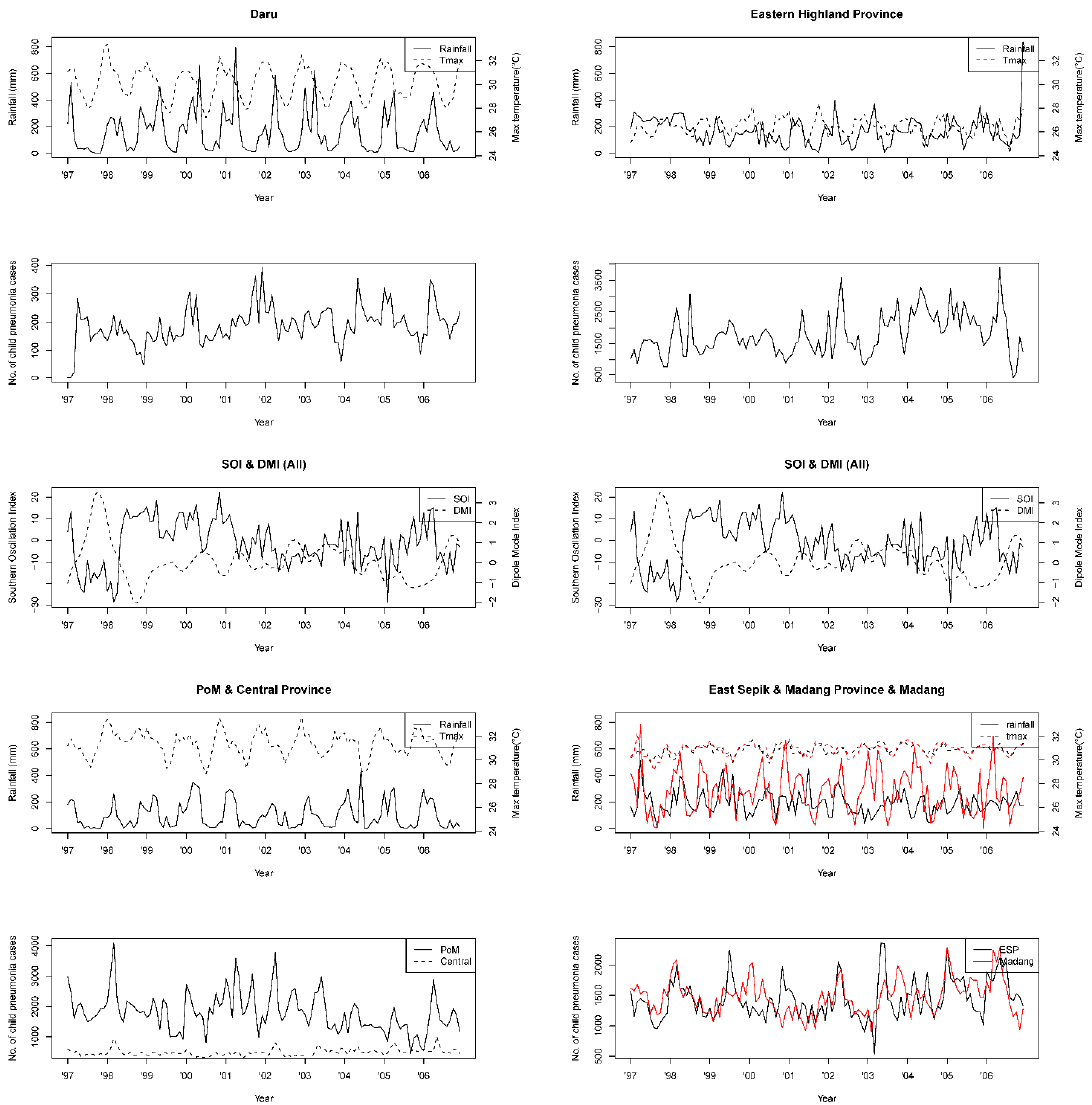
Figure 2. Monthly time-series: childhood pneumonia cases in children aged five years; rainfall, max temperature (°C), dipole mode index (DMI), southern oscillation index (SOI), from 1997 to 2006.